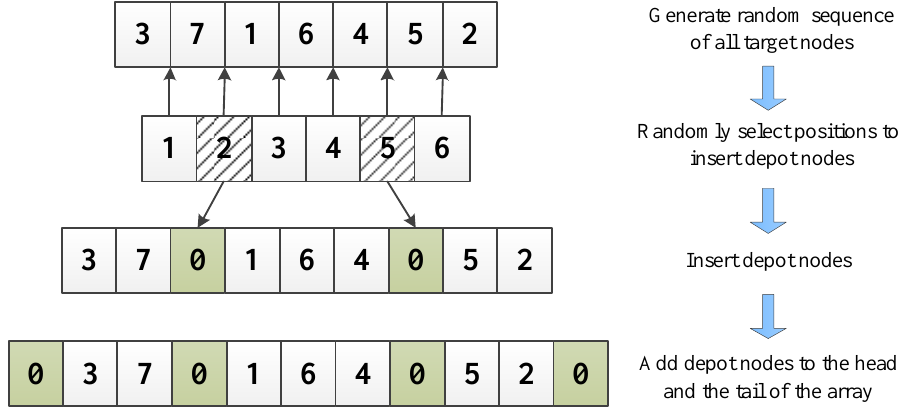
Figure 3. Basic procedure for generating a feasible solution. UAV number M = 3, target nodes number N =